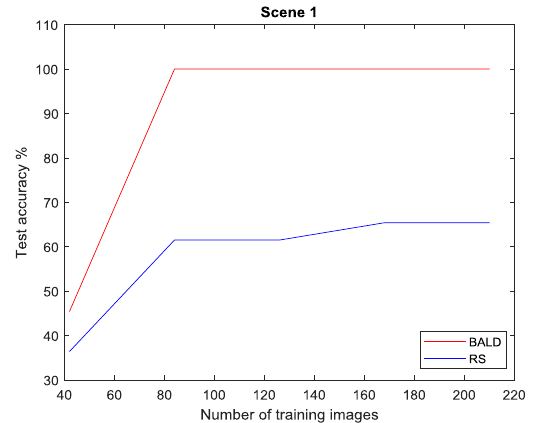
Figure 6 . Test accuracy as a function of the number of training images. Results from the acquisition functions Bayesian active learning disagreement and random sampling are demonstrated for “Scene